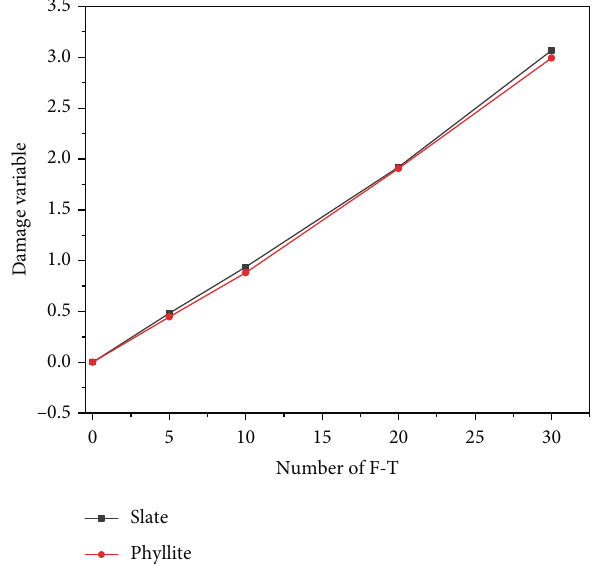
Figure 12: Damage variables of specimens under di ff erent hydrothermal conditions versus the number of